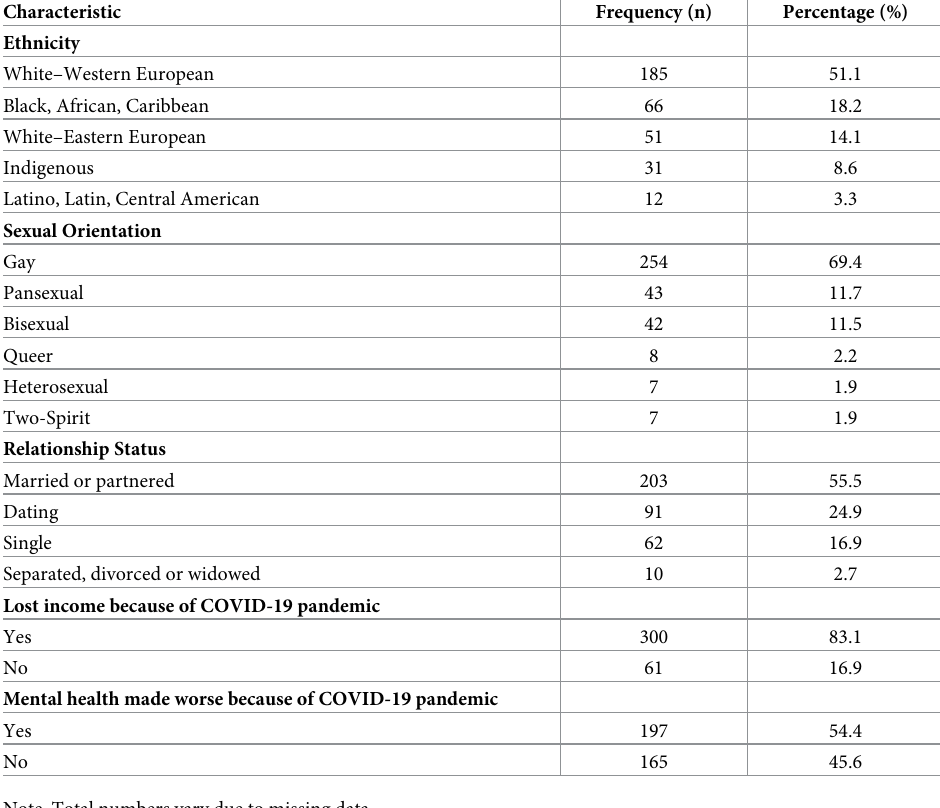
Table 1. Socio-demographic characteristics and descriptive findings ( N =